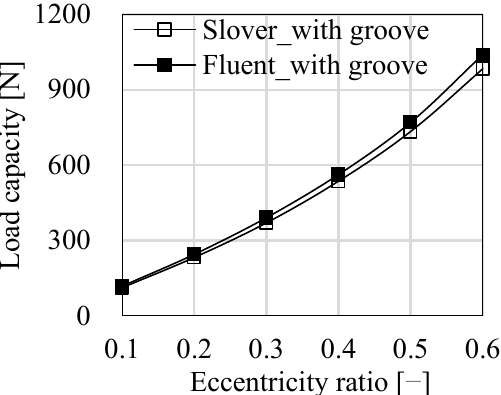
Figure 7. Comparisons of the load capacity between Fluent and the in-house solver.